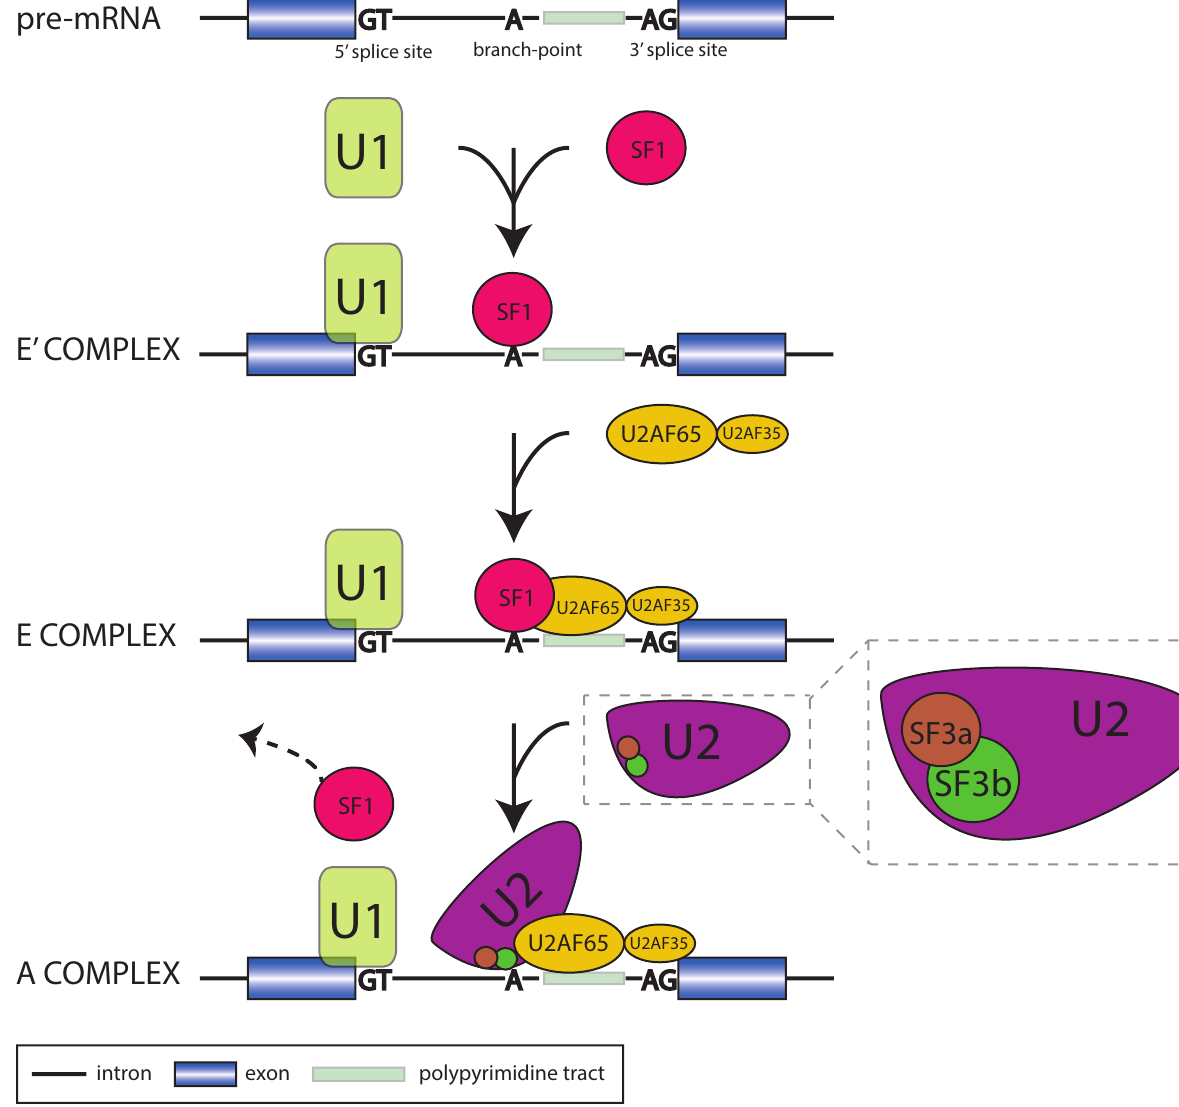
Figure 1. Stepwise assembly of the early splicesome highlighting the known splicing factors that bind to the